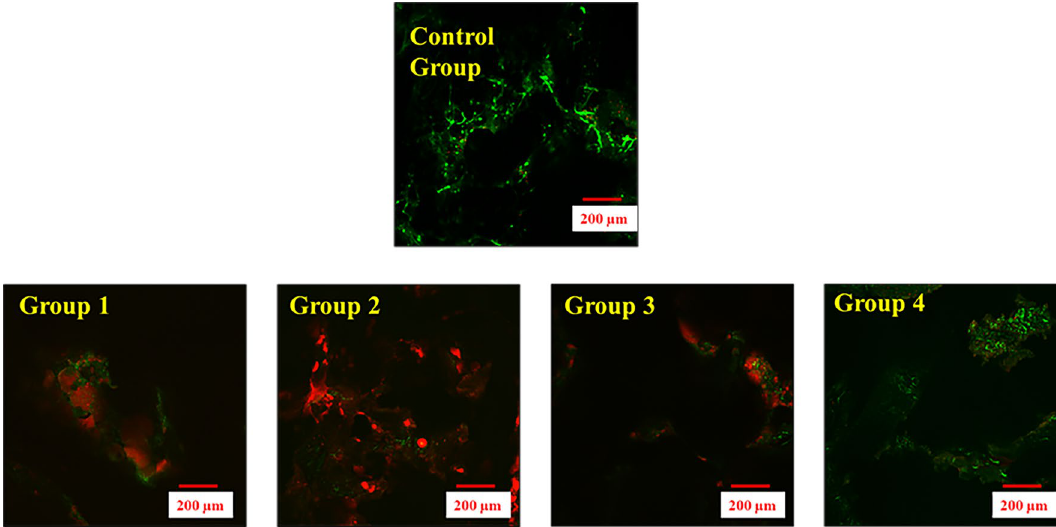
Figure 3. Live Dead Assay of bone coupons for different groups at week 7. Group 1) Isolated bone cores placed in static culture, Group 2) Unloaded bone cores placed in static culture in contact with a fiber-mesh metallic scaffold, Group 3) Bone cores placed in contact with a fiber-mesh metallic scaffold under the constant pressure of 150 kPa, Group 4) Bone core placed in contact with a fiber-mesh metallic scaffold and exposed to cyclic loading with continuous perfusion flow of media within the ex-vivo culture system. Green color indicates the live cells while red color indicates the dead cells. Live cells, similar to control group (Positive Control Bone Core at Day 0) were observed in Group 4 while dead cells were observed in Groups (1–3).